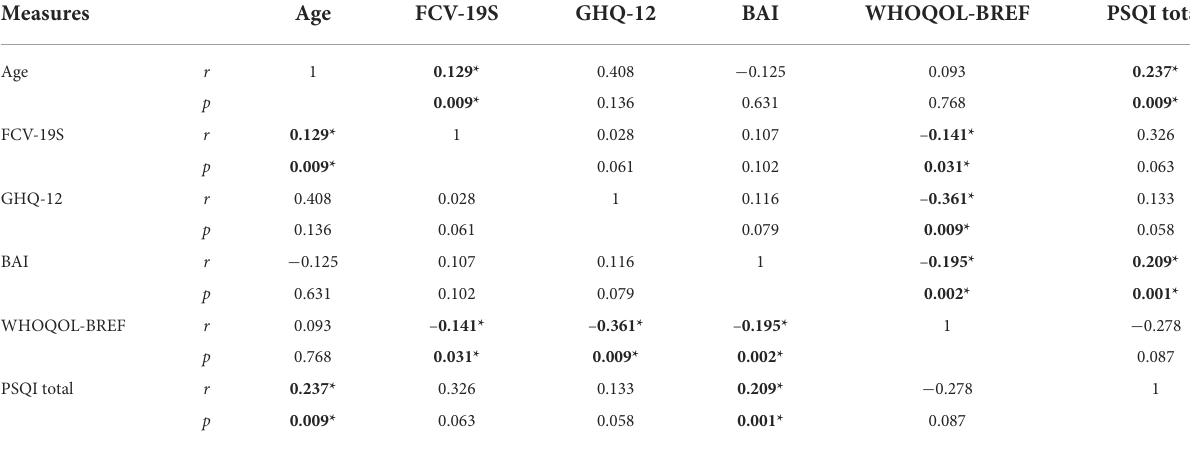
TABLE 5 Correlation analysis between our suggested measures (Iran).